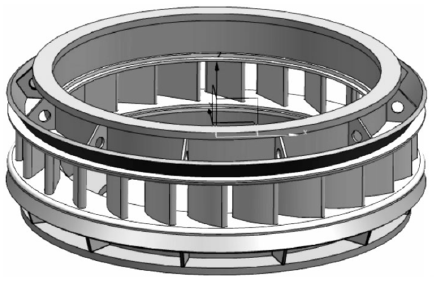
Figure 1. Shape of SXQ500/550DZ35 in hydropower station.